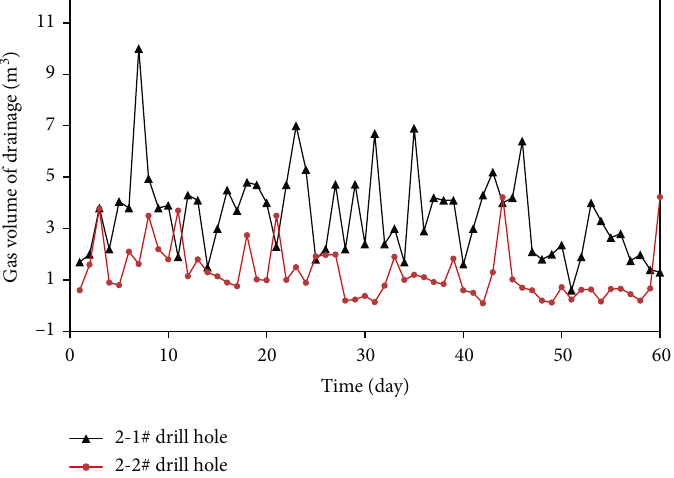
Figure 7: Gas extraction in the borehole group